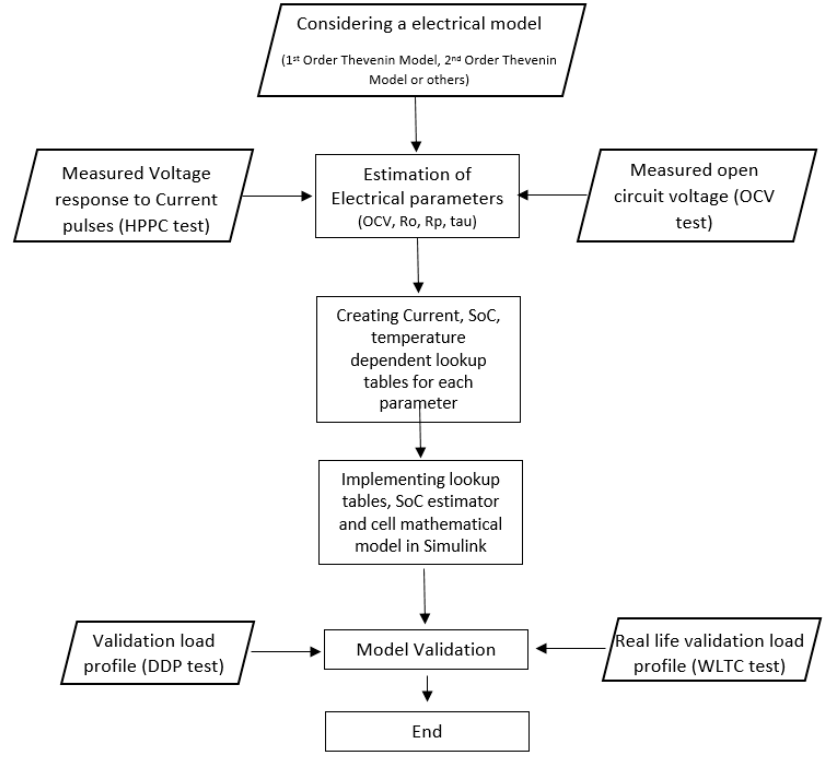
Figure 1. Schematic representation of the activities to create an equivalent circuit model (ECM) model.